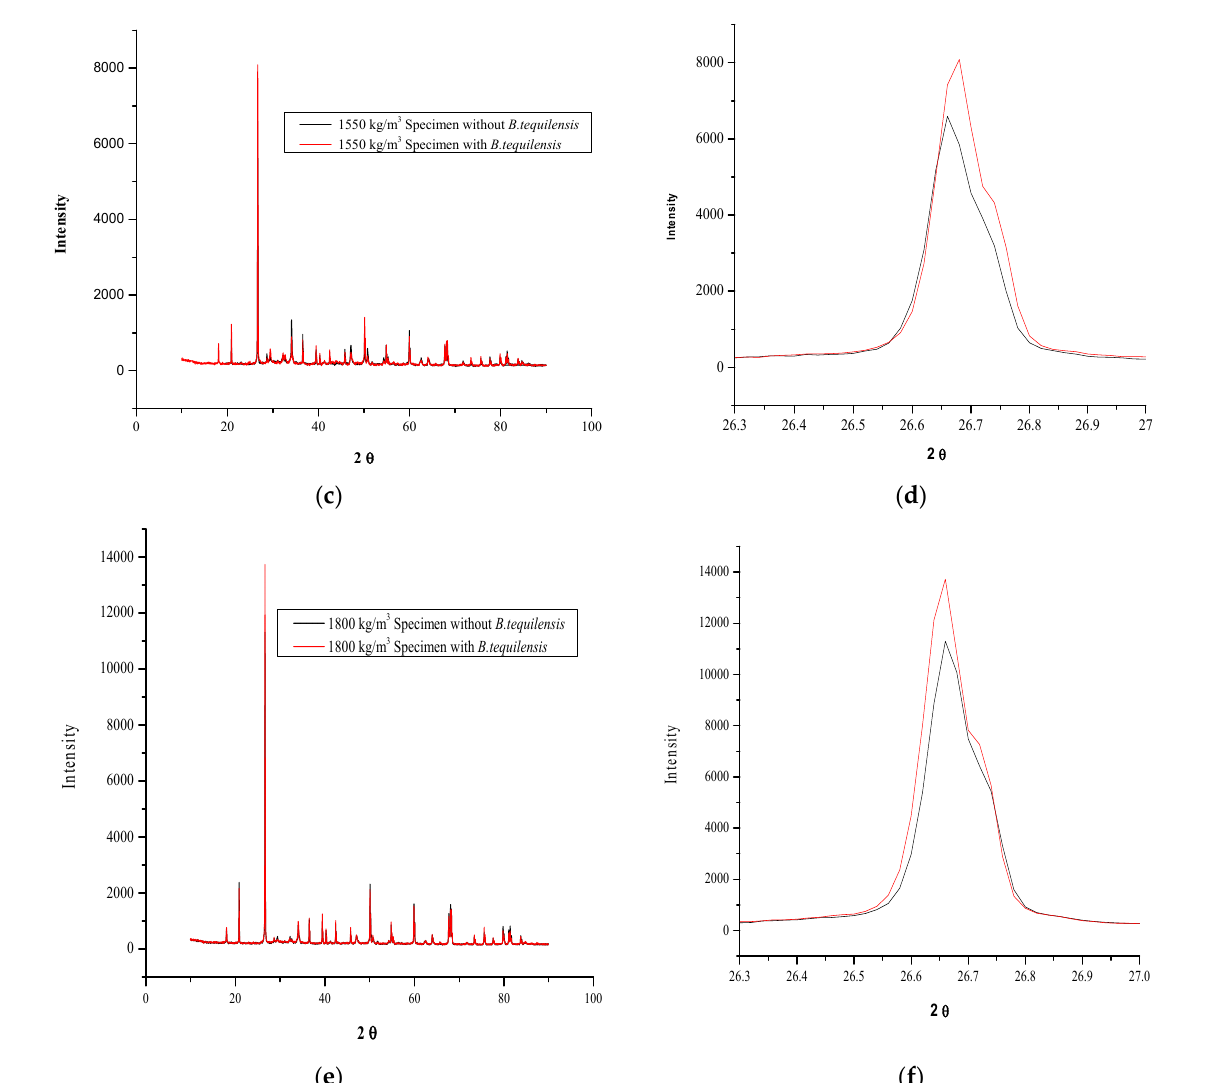
Figure 10. XRD analysis comparison between FCB and B-FCB at 28 days, ( a ) Specimens with 1300 kg/m 3 of density, ( b ) The highest peak at specimen with 1300 kg/m 3 of density, ( c ) Specimens with 1550 kg/m 3 of density, ( d ) The highest peak at specimen with 1550 kg/m 3 of density ( e ) Specimens with 1800 kg/m 3 of density, ( f ) The highest peak at specimen with 1800 kg/m 3 of density .